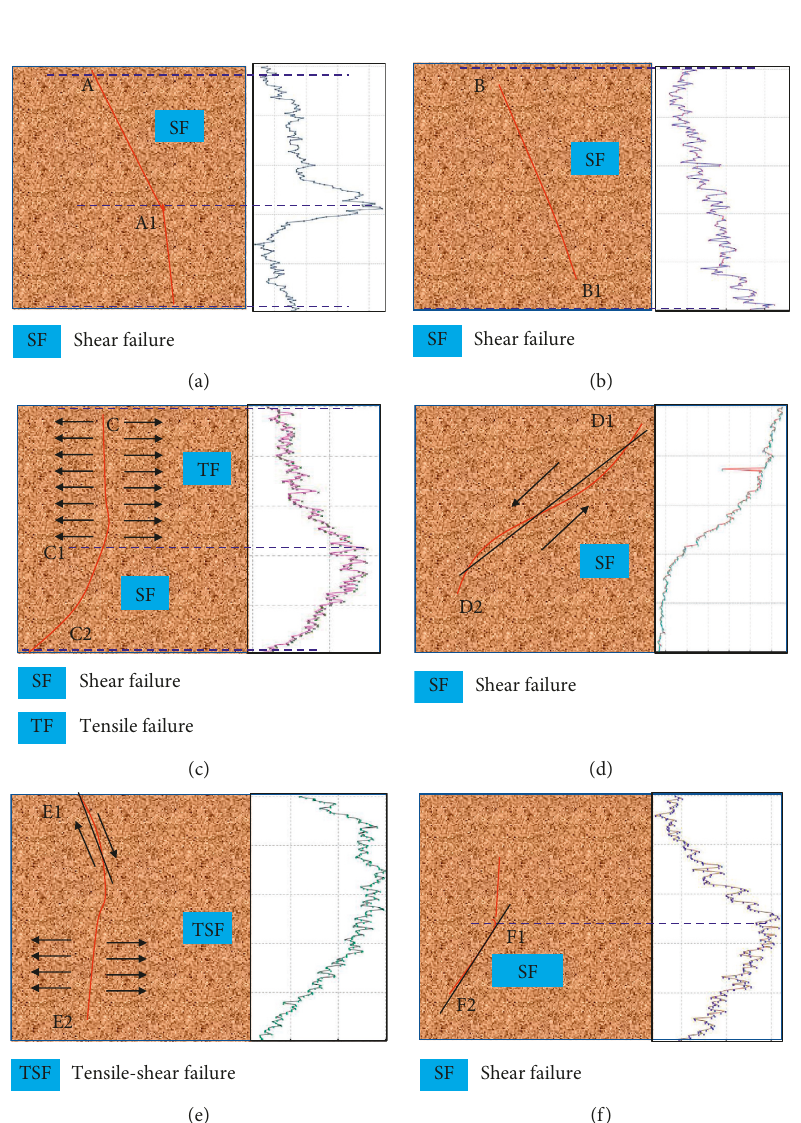
Figure 9: Comparison of structural failure modes and crystal spatial distribution at different strengths: (a) 0.62MPa; (b) 1.66MPa; (c) 2.81MPa; (d) 3.20MPa; (e) 4.61MPa; (f) 7.33MPa. TF: tensile failure; SF: shear failure; TSF: tensile-shear